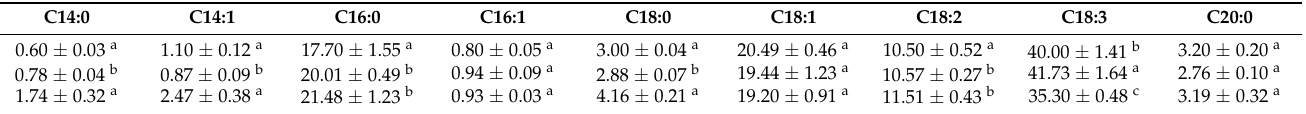
Table 2. Fatty acid composition (%) of leaf lipids of olive plants cv. ’Chetoui’ subjected to subsequent drought stress. Significant differences between the means (at p < 0.05, according to ANOVA) appear with different letters. Values are means ± standard error ( n = 6), where ‘ n ’ is the number of replicates for each group.